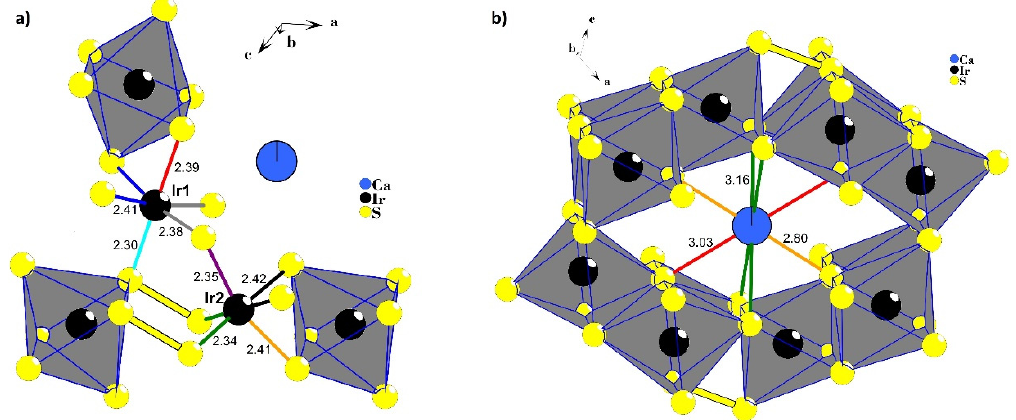
Figure 4. Ir ( a ) and Ca ( b ) coordination in CaIr 4 S 6 (S 2 ) with bond lengths in Å. Bonds shown in the same color have the same length. Table 1. Crystal structure data for Ca 1 − x Ir 4 S 6 (S 2 ) obtained from JANA2006 refinement. The refined